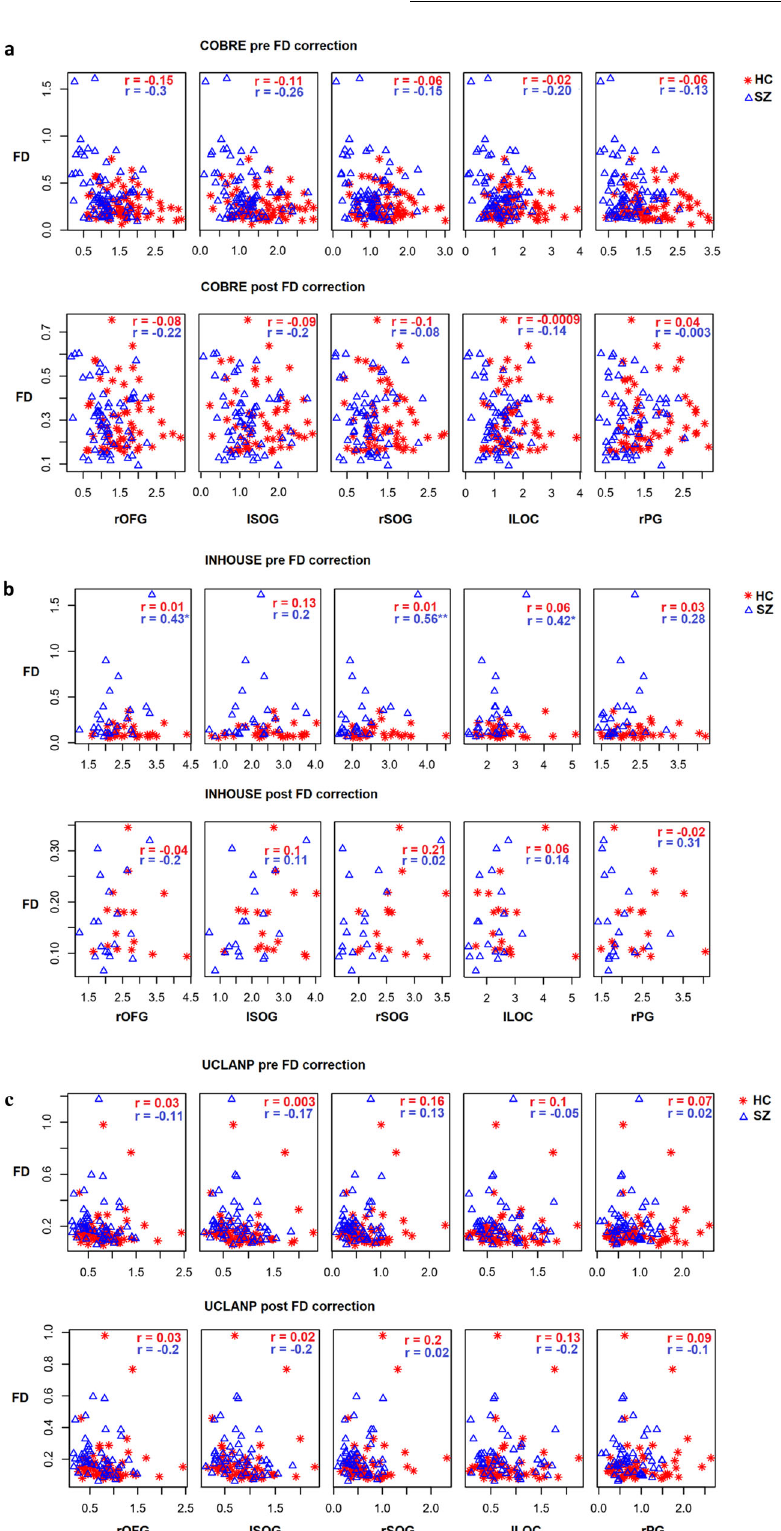
Fig. 4 Correlations between framewise displacement (FD) and intrinsic neural timescales (INT), before and after FD outlier elimination, per sample and cluster. COBRE in panel a , INHOUSE in panel b , and UCLANP in panel c . Red star symbols represent correlations between FD and INT in HC, while blue triangle symbols represent correlations between FD and INT in SZ. Correlation coef fi cients are written in red for HC and blue for SZ. The asterisk indicates a P < 0.05 signi fi cance